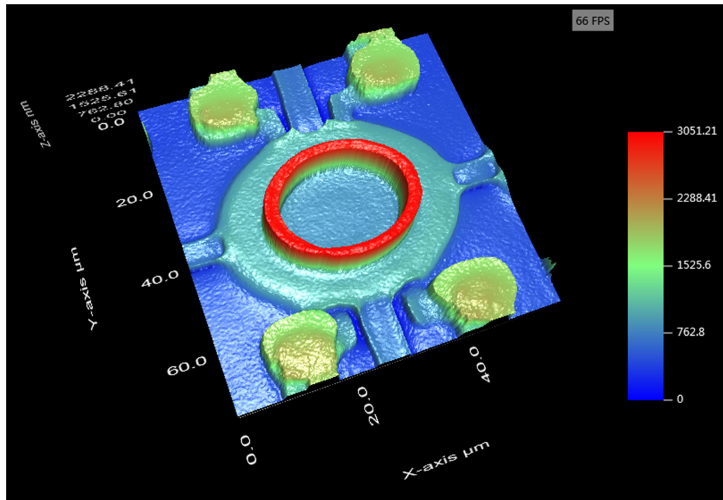
Figure 5. Pseudo-color image of an embossed CMUT (The scale in z-axis was not the same to x-axis and y-axis).